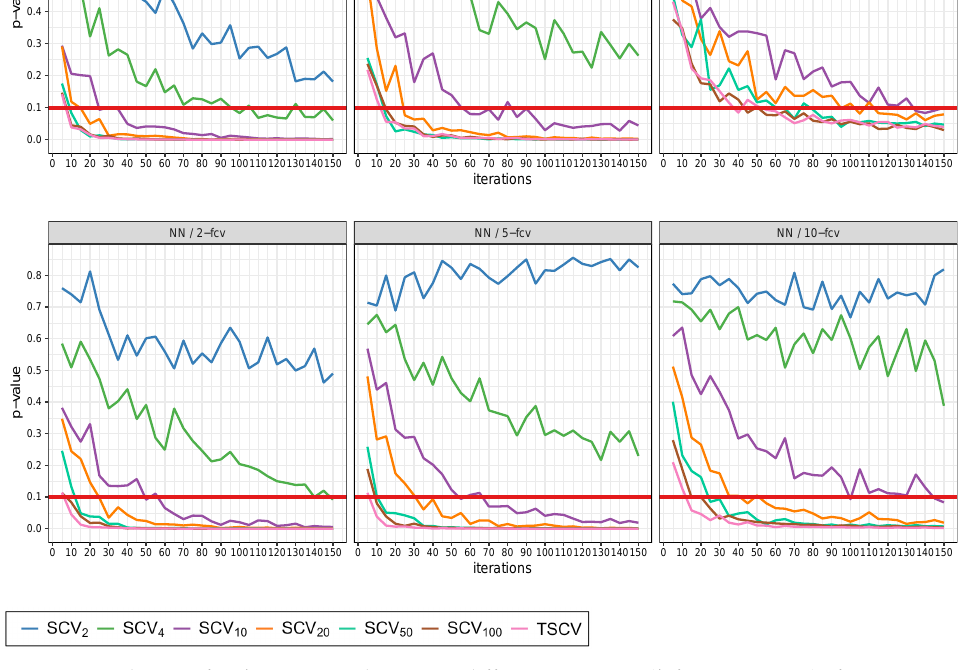
Figure 2. Evolution of Wilcoxon ’s p -value across different iterations ( k -fcv repetitions) after comparing each stratification scheme against not considering stratification with CV using RPART and NN